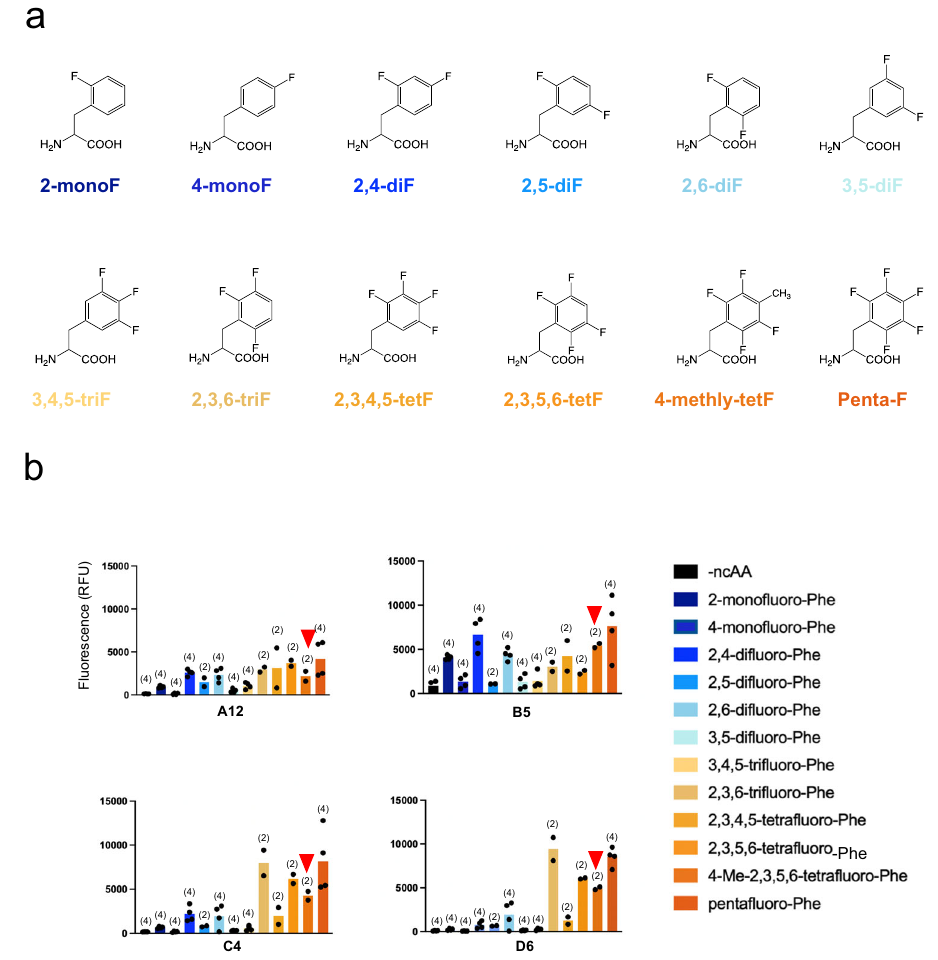
Fig. 3 | Permissivity of the identi fi ed synthetases. a Chemical structures of the fl uorinated phenylalanine residues used in the screen. b Green fl uorescence from the rescue of sfGFP-N150TAG in E. coli using 1mM of each ncAA after 24-h incu- bation. N values of independent expressions in parentheses with bar height